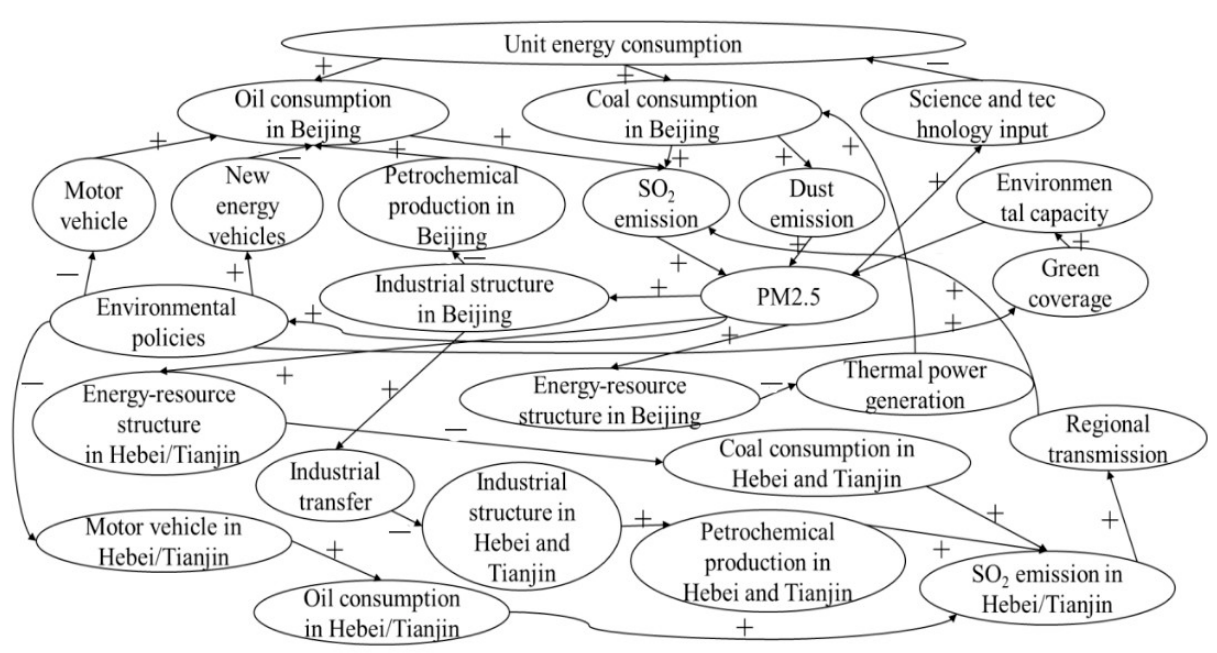
Figure 9. Overall causality diagram of Beijing urban haze system.